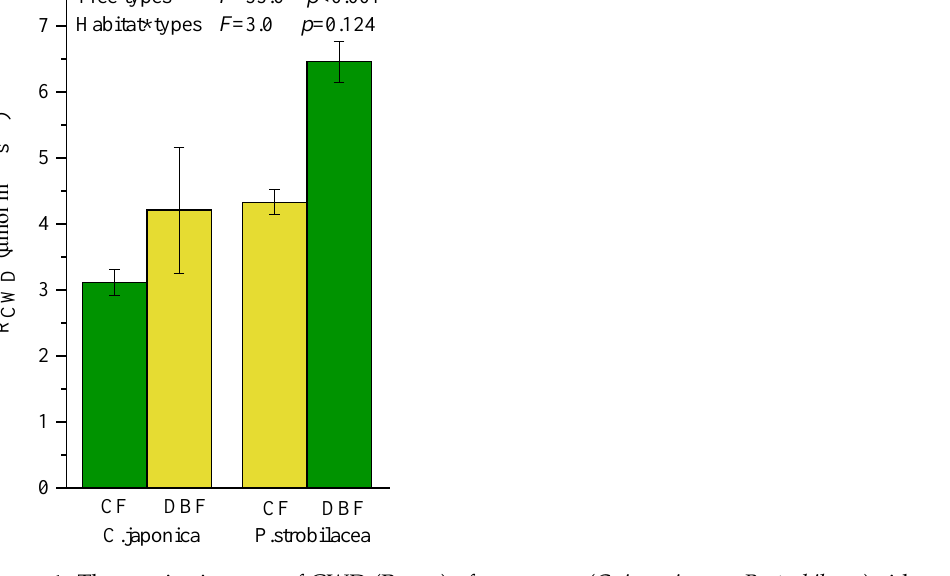
Figure 1. The respiration rate of CWD (R CWD ) of two types ( C. japonica vs. P. strobilacea ) either at “home” (green bars) or “away” (yellow bars). CWD: coarse woody debris; CF: coniferous forest; DBF: deciduous broadleaf forest. Values are mean ± standard error ( n = 3).